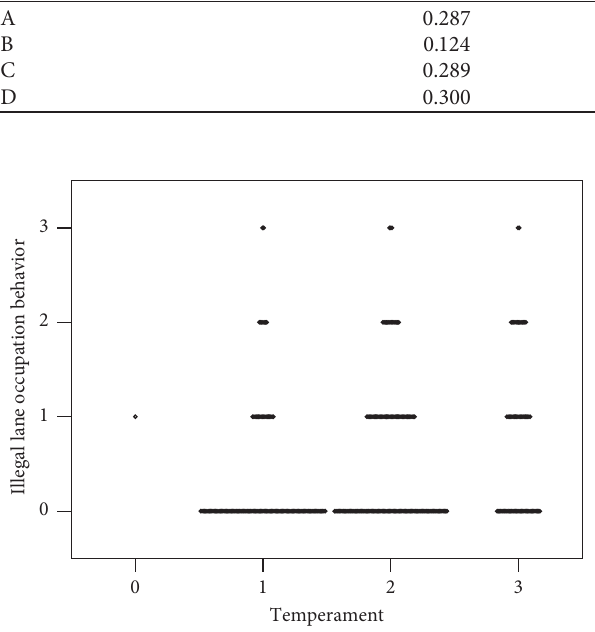
Figure 4: Relationship between temperament and illegal lane occupation behavior.